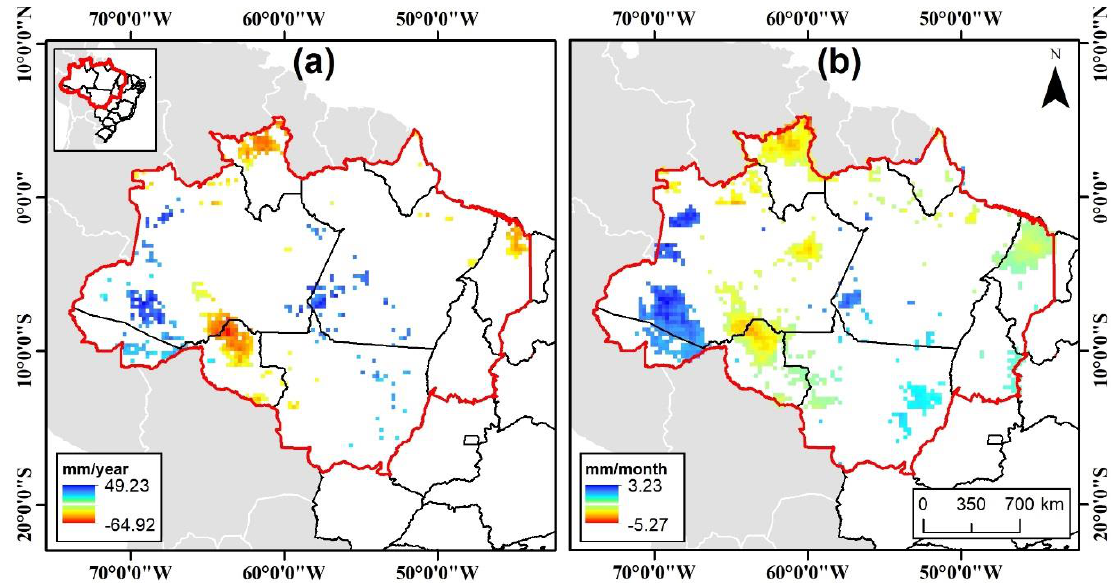
Figure 3. Spatial distribution of significant annual rainfall trends (Sen’s slope; p ≤ 0.05). Positive trends, indicating an increase in rainfall, are displayed in blue and negative trends, indicating a decrease in rainfall, are in red. ( a ) Annual rainfall trends and ( b ) seasonal rainfall trends.